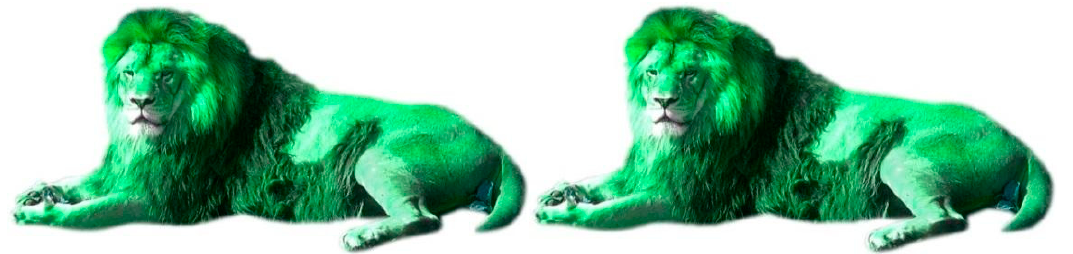
Figure 1. Task sample, picture and stimuli (definite plural noun phrase (NP)— Are the lions green? bare NP— Are lions green? )